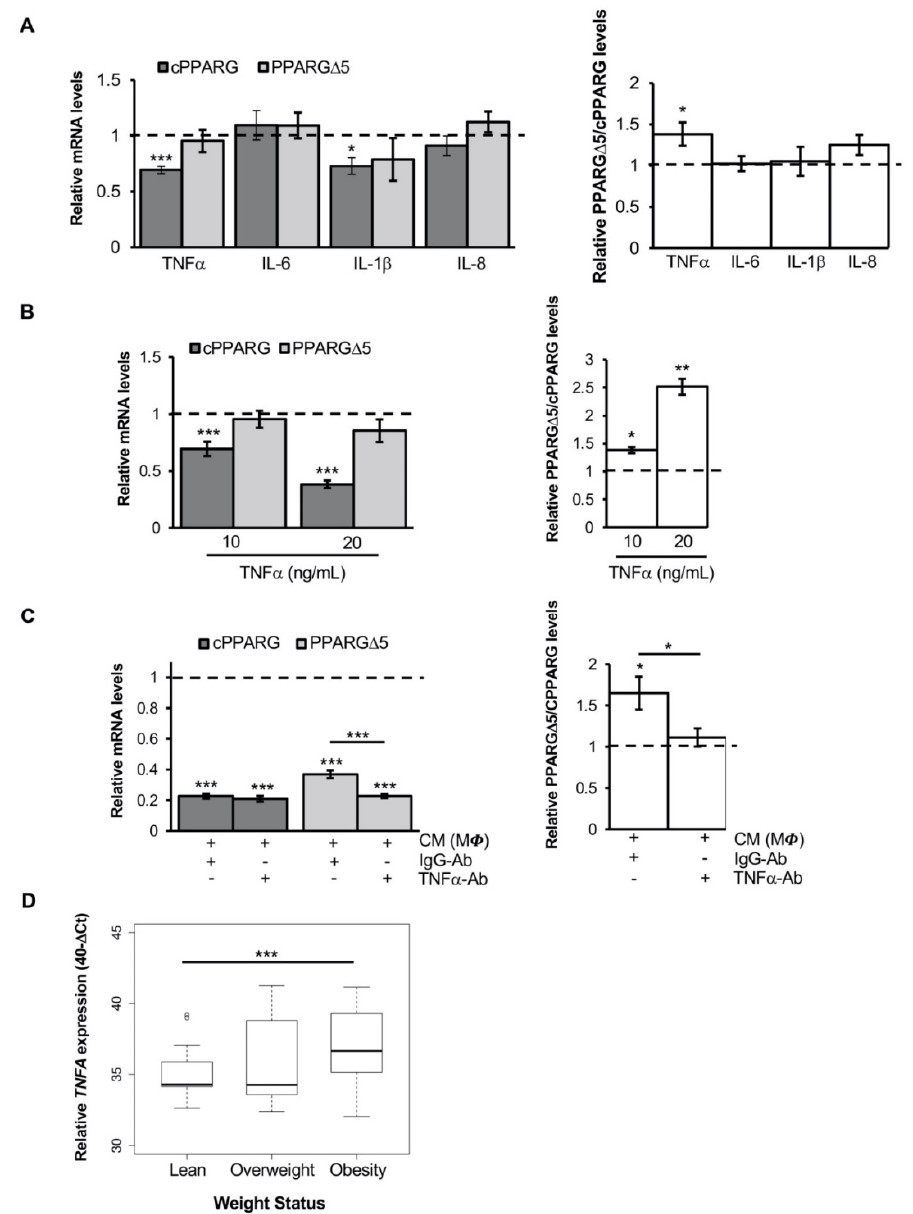
Figure 3. TNF α increases the PPARG ∆ 5/cPPARG ratio in adipocyte precursor cells and correlates with PPARG ∆ 5 expression in obese patients: ( A ) Relative mRNA quantification (qPCR) of cPPARG, PPARG ∆ 5 (left panel) and the PPARG ∆ 5/cPPARG ratio (right panel) in undifferentiated hMSCs treated for 24 h with 10 ng/mL of human recombinant TNF α , IL-6, IL-1 β or IL-8 cytokines. hMSCs treated with vehicle (i.e., PBS) were used as reference samples (dotted lines) and PPIA as reference gene. Data are reported as mean ± SEM of at least three independent experiments. * p ≤ 0.051 and *** p ≤ 0.001. ( B ) Relative mRNA quantification (qPCR) of cPPARG, PPARG ∆ 5 (left panel) and the PPARG ∆ 5/cPPARG ratio (right panel) in hMSCs at undifferentiated stage treated for 24 h with 10 or 20 ng/mL of human recombinant TNF α cytokine. hMSCs treated with vehicle (i.e., PBS) were used as reference samples (dotted lines) and PPIA as reference gene. Data are reported as mean ± SEM of at least three independent experiments. * p ≤ 0.05, ** p ≤ 0.01 and *** p ≤ 0.001. ( C ) Relative mRNA quantification (qPCR) of cPPARG, PPARG ∆ 5 (left panel) and the PPARG ∆ 5/cPPARG ratio (right panel) in undifferentiated hMSCs treated for 24 h with conditioned medium (CM) of